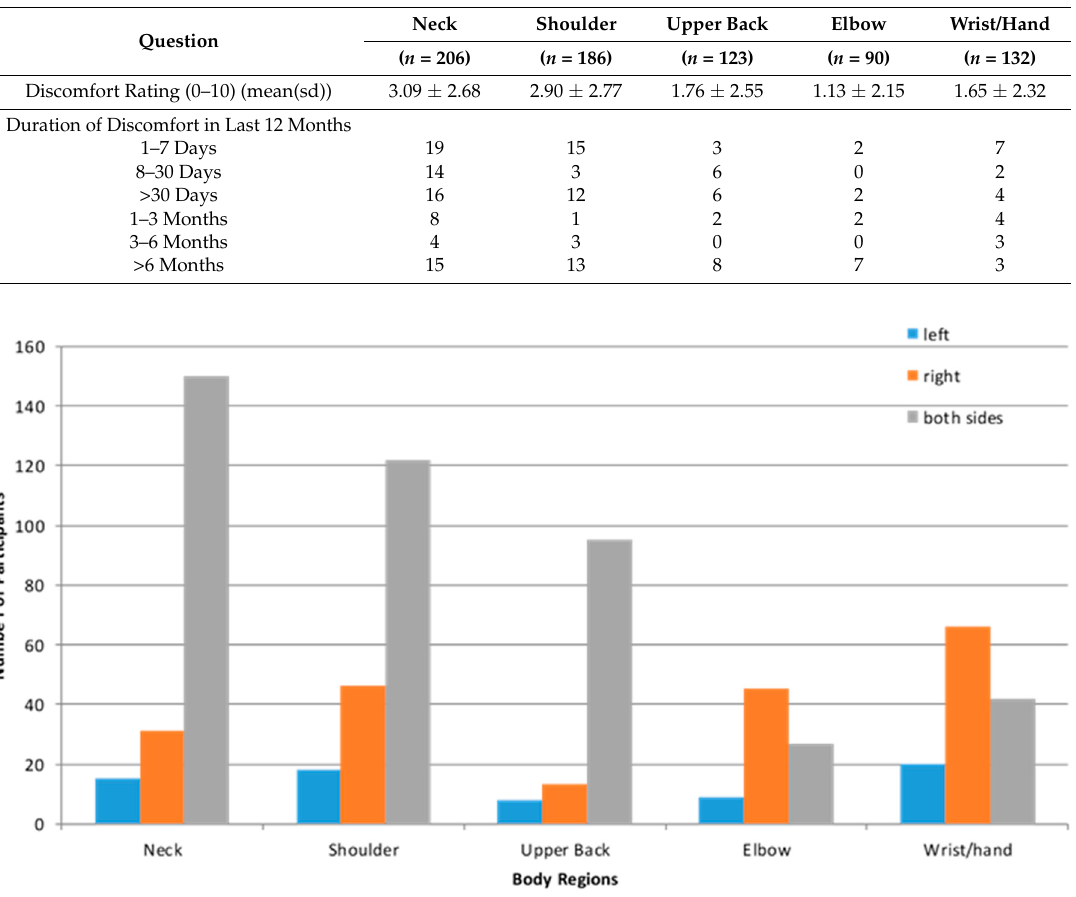
Figure 1. 12 months prevalence of musculoskeletal discomfort in different body regions, and frequencies of left, right and bilateral